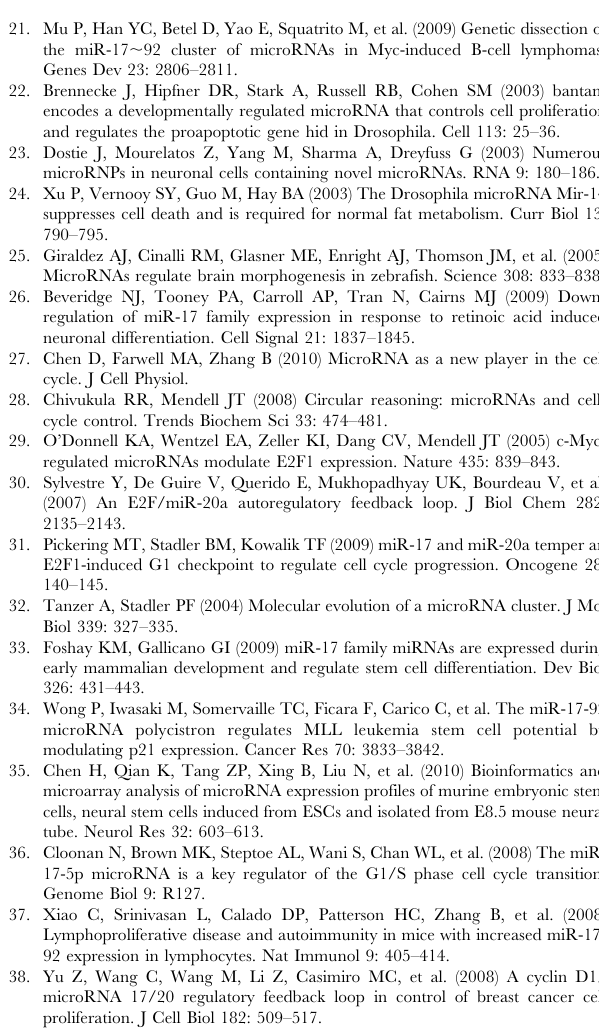
INTERSECTION shows targets predicted by algorithms PicTar AND TargetScanS within the DIANA webtool. Figure S4 Summary of effects of an unspecific negative control on each 3 9 -UTR used in target validations. For details refer to Fig. 2. Mean values from 2 biological experiments, each performed in 4 technical replicates are given. Error bars represent standard deviations and statistical significancies (Stu- dent’s t -test, unpaired, *: p # 0.05) are indicated. No significant